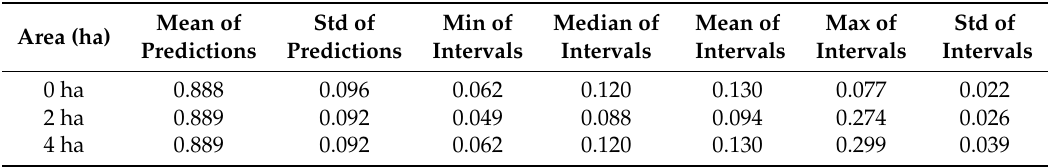
Table 7. Examples of the statistics of the 95% confidence intervals of the predictions of the probability of the category with the largest probability when the Sentinel-1 scenes from the period 1 June–12 August 2017 were used. The statistics are shown by the threshold of the minimum of the parcel area. Mean of Std of Min of Median of Mean of Max of Std of Area (ha) Predictions Predictions Intervals Intervals Intervals Intervals Intervals 0 ha